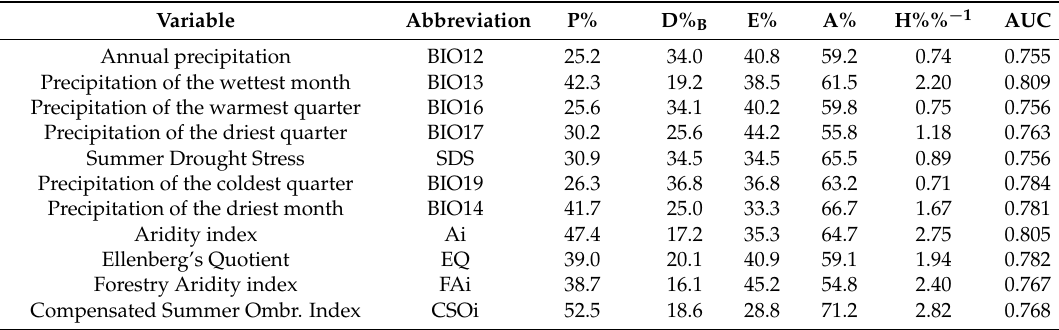
Table 2. Distribution response functions (P, D and E) and measures (A, H and AUC) for beech forests referring to 27 bioclimatic variables listed by ascending order of principal components (from PC-1 to PC-4) and descending order of factor loadings (see also Table 1). P = Prevalence response function, D = Decay response function, E = Exclusion response function, A = Amplitude (P + D sum), H = Hardiness (P/D ratio), AUC = Area under the Curve (ratio, derived from ROC analysis). For detailed explanation of response functions and measures and description of bioclimatic variables see Sections 2.4 and